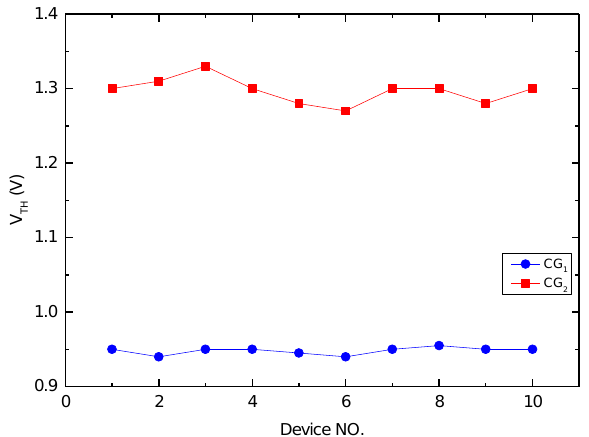
Figure 8. The threshold voltages for two control gates of 10 devices, where the average threshold voltage for CG 1 is 0.95 V and that for CG 1 is 1.3 V.